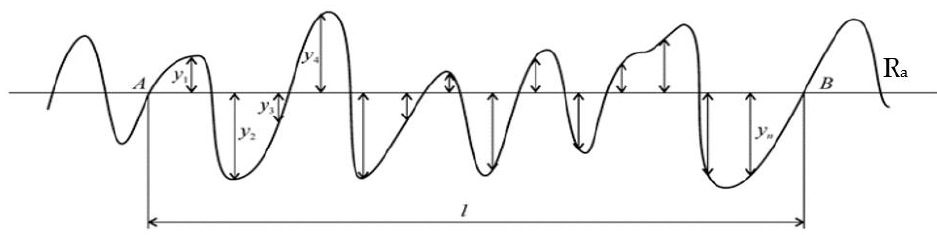
Figure 4. Mean roughness value Ra.